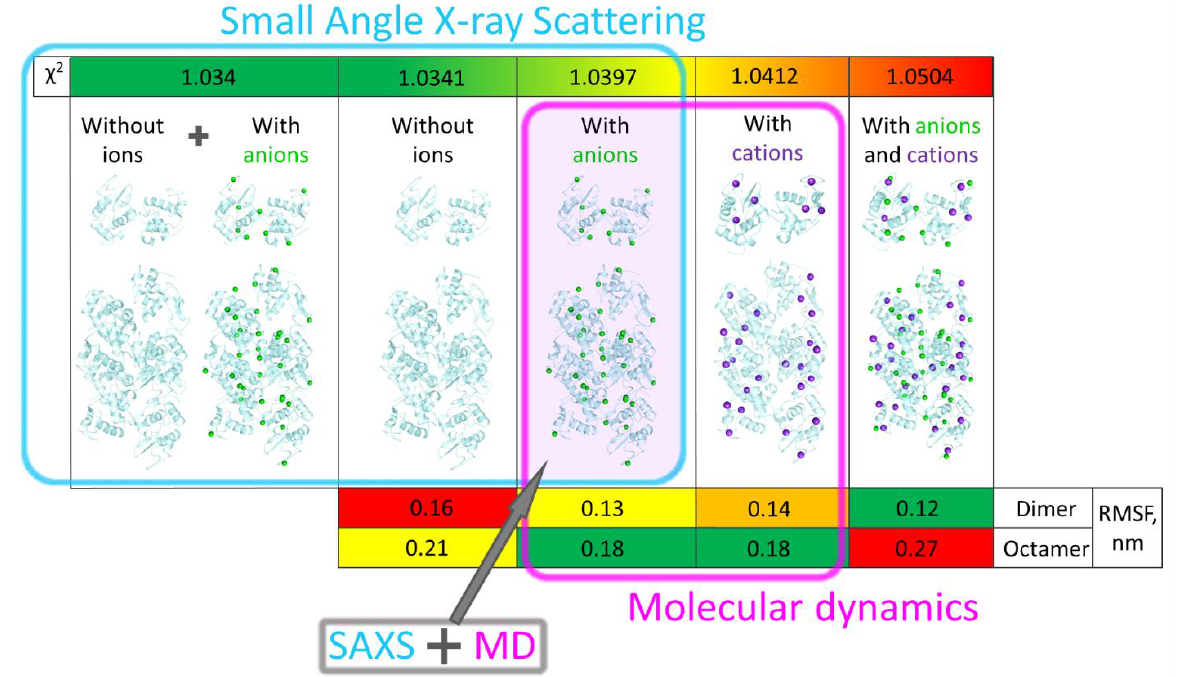
Figure 2. The comparison of results drawn from SAXS and MD data analysis.